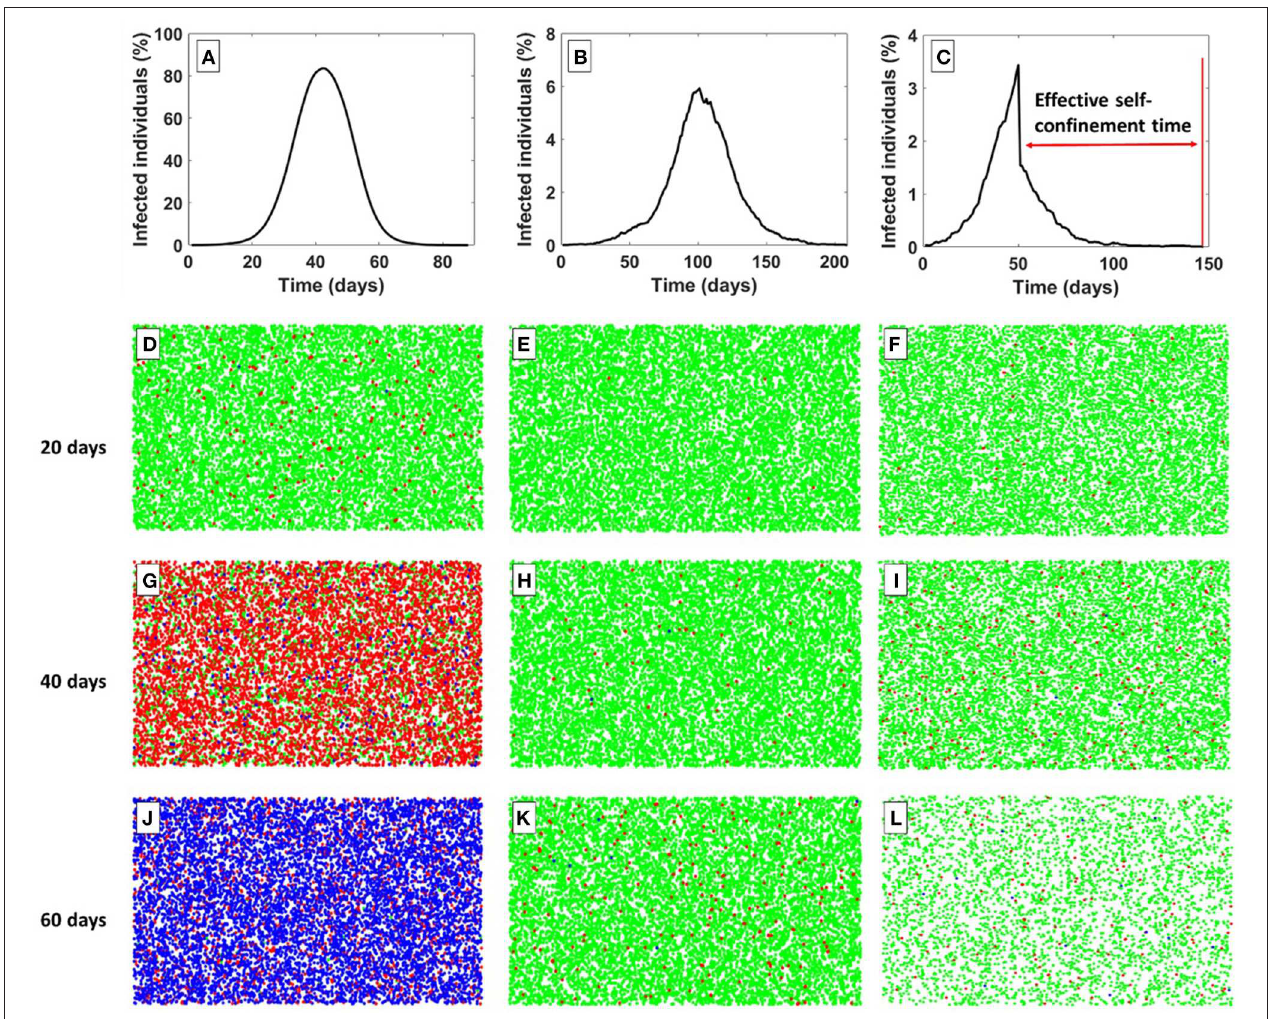
FIGURE 1 | Examples of different simulations performed with our Monte Carlo stochastic model. (A) Variation of infected individuals with time for a scenario in which: (i) virus carriers are never detected (all of them are assumed asymptomatic) nor removed from the domain (probability of not detecting infected individuals, P und = 100 % ), and (ii) no part of the population is confined (duration of free spread of the outbreak, τ free → ∞ ). (B) Variation of infected individuals with time for a scenario in which: (i) there is a P und = 85 % chance that virus carriers are not detected, (ii) infected individuals detected are removed from the domain, and (iii) no confinement of part of the population is imposed ( τ free → ∞ ). (C) Variation of infected individuals with time for a scenario in which: (i) there is a P und = 85 % chance that virus carriers are not detected, (ii) infected individuals detected are removed from the domain, and (iii) confinement of 60% of the population is imposed after τ free = 50 days of free spread of the outbreak. (D–L) Healthy (green), infected (red), and immune (blue) individuals, as predicted with our model, after 20, 40, and 60 days since the onset of the outbreak and for each of the scenarios above. For the rest of the parameters of the model, we use: number of individuals, N = 11,000; duration of viral shedding, τ shed = 20 days; radius of influence, r inf = 4 m ; and probability of infection, P inf = 50 % . We use 1 day time step. A Matlab script with the model can be found in Supplementary Material